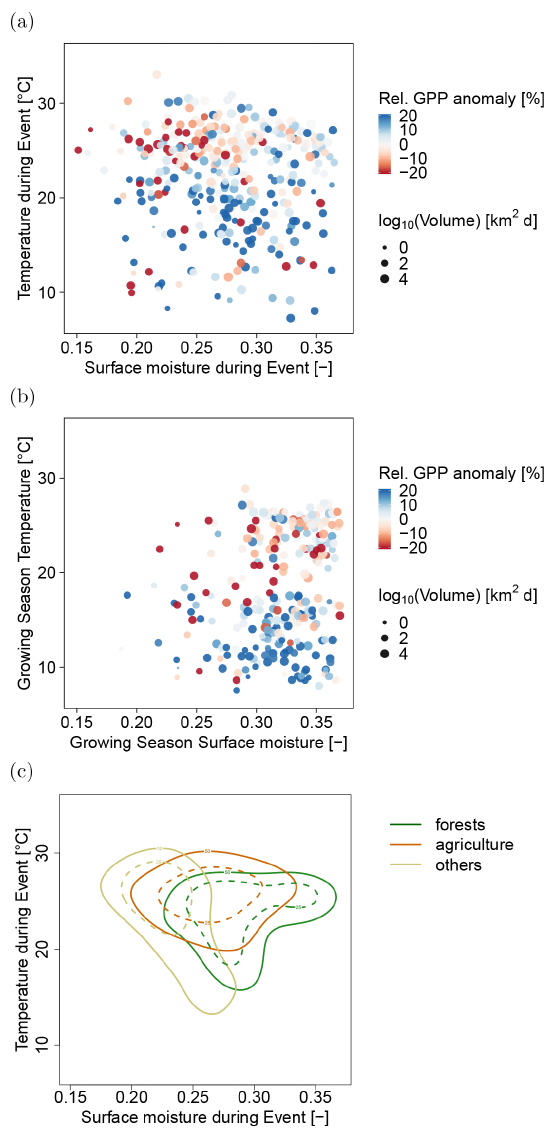
Figure 4. (a) Mean temperature and surface moisture during the relative drought and heat events and (b) growing season temperature and growing season surface moisture for forests and agricultural ecosystems. Size and color of the points denote the affected space– time volume and the direction of the impact on productivity. (c) Average conditions in temperature and surface moisture during the events for all ecosystems. Colored lines enclose 25% (dashed lines) and 50% (solid lines) of the events within forest, agricultural, and other